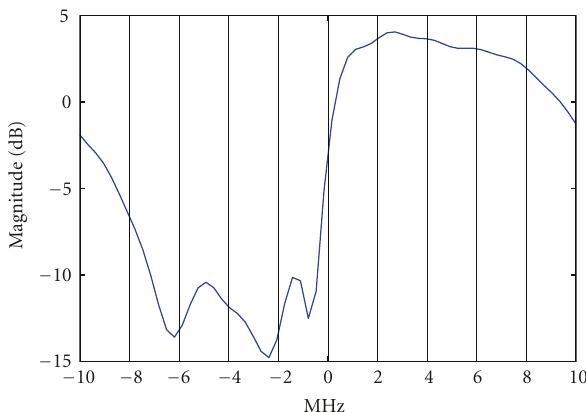
Figure 1: Example of the baseband transfer function of a frequency-selective channel model